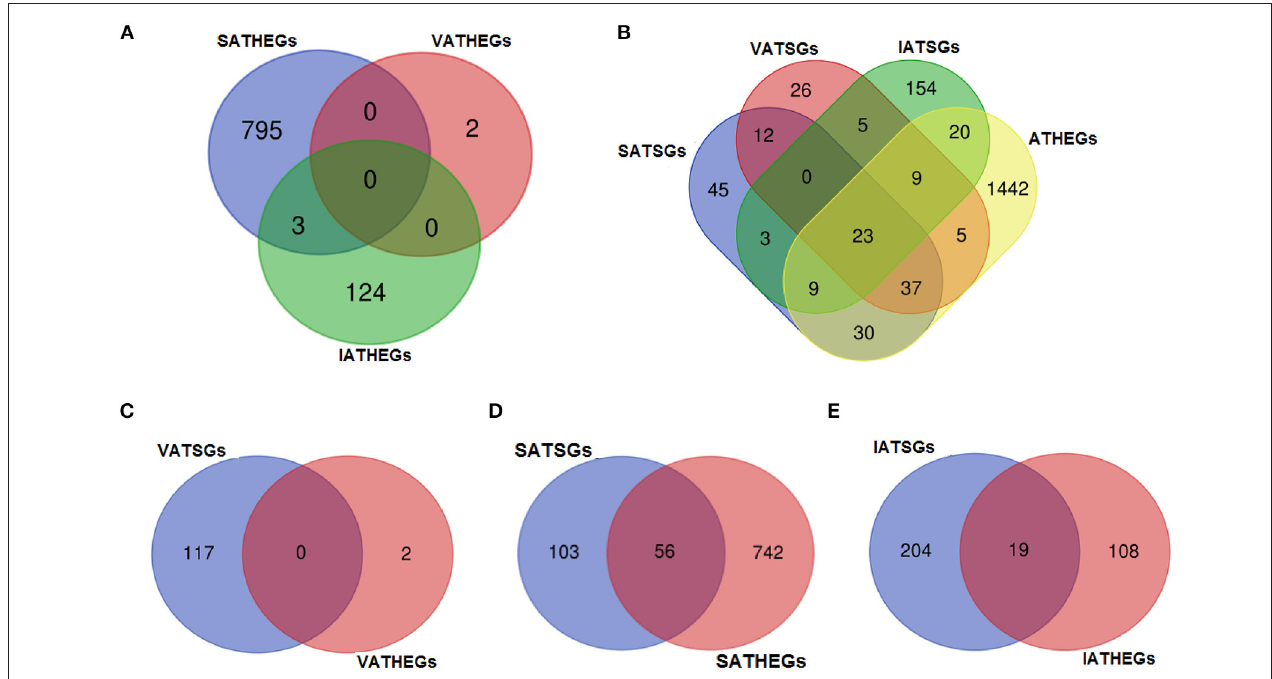
FIGURE 8 | The numbers of the gene belonging to different groups. VA, visceral adipose; SA, subcutaneous adipose; IA, intramuscular adipose; HEGs, genes significantly higher expressed in tissue; TSGs, tissue-specific genes.